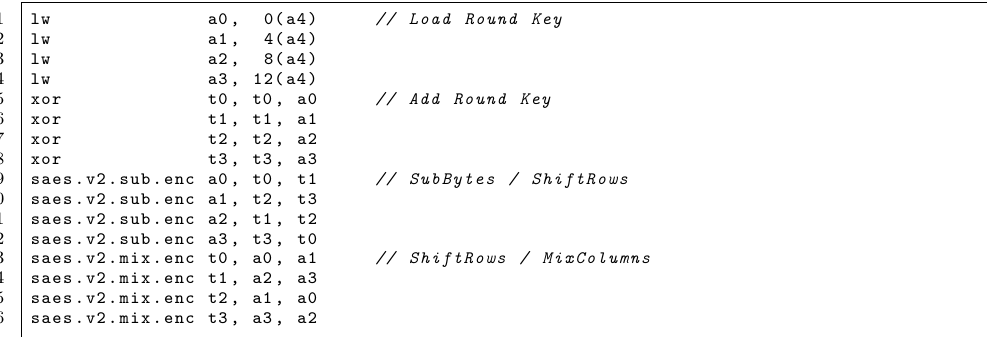
Figure 8: An AES encryption round implemented using V 2